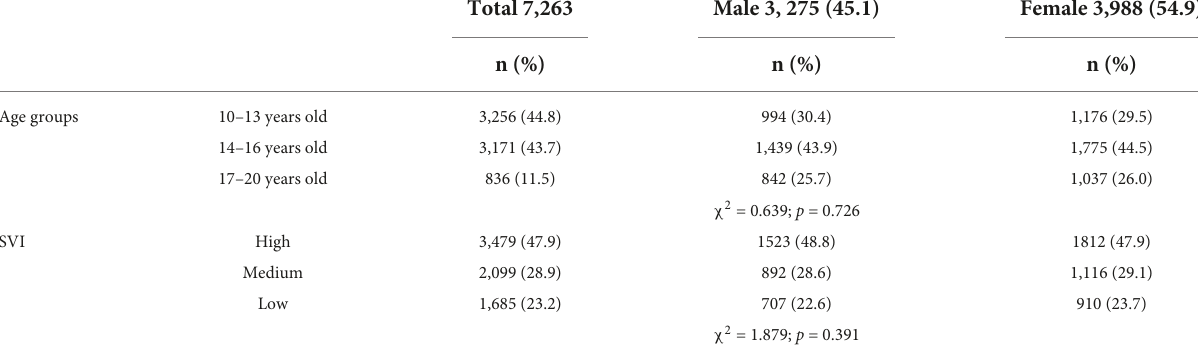
TABLE 1 Participants’ characteristics ( N =